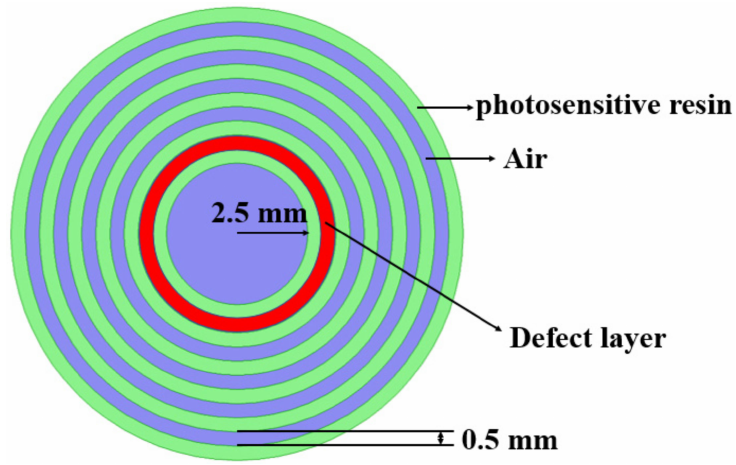
Figure 2. Cross section of the proposed THz Bragg